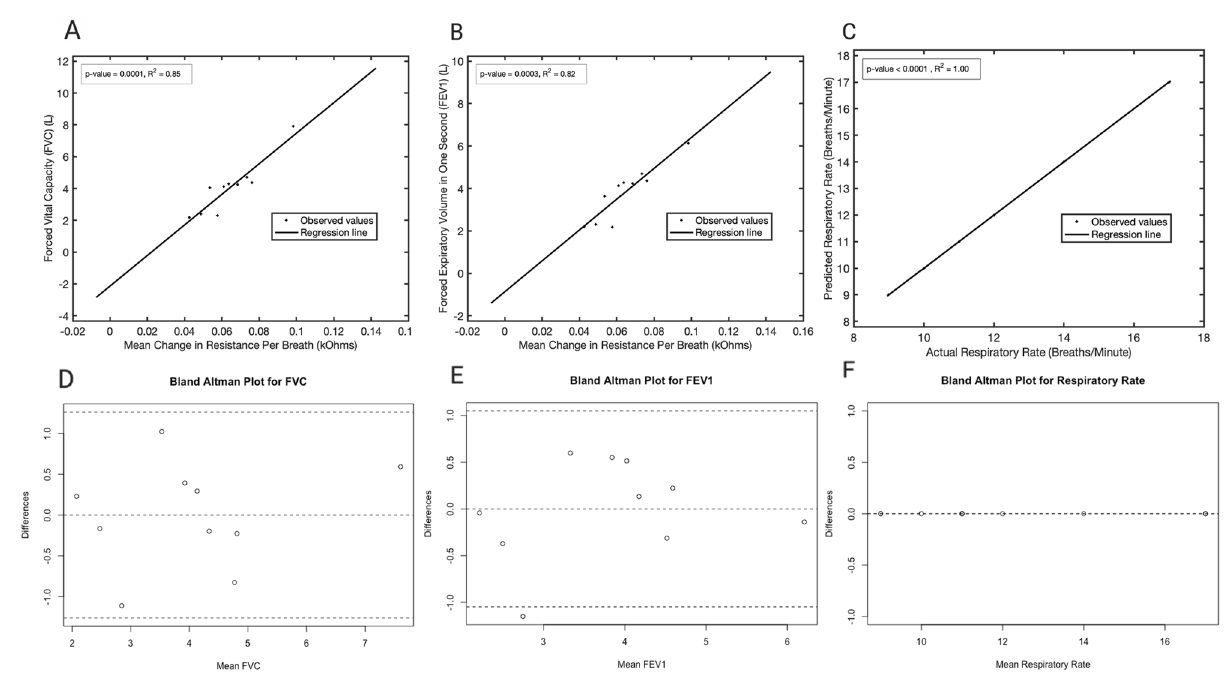
Figure 5. Regression analyses. ( A ) Linear regression analysis correlating mean change in parallel resistance per breath and FVC. ( B ) Linear regression analysis correlating mean change in parallel resistance per breath and FEV 1 . ( C ) Linear regression analysis correlating predicted and actual respiratory rates. ( D–F ) Bland–Altman plots for FVC, FEV 1 , and RR